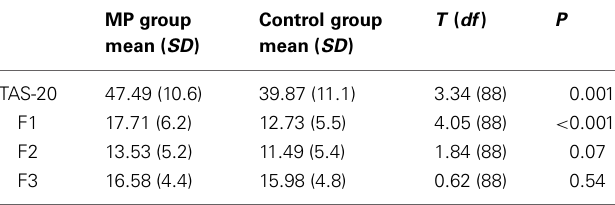
Table 4 | Alexithymia data of the myofascial pain (MP) group and the control